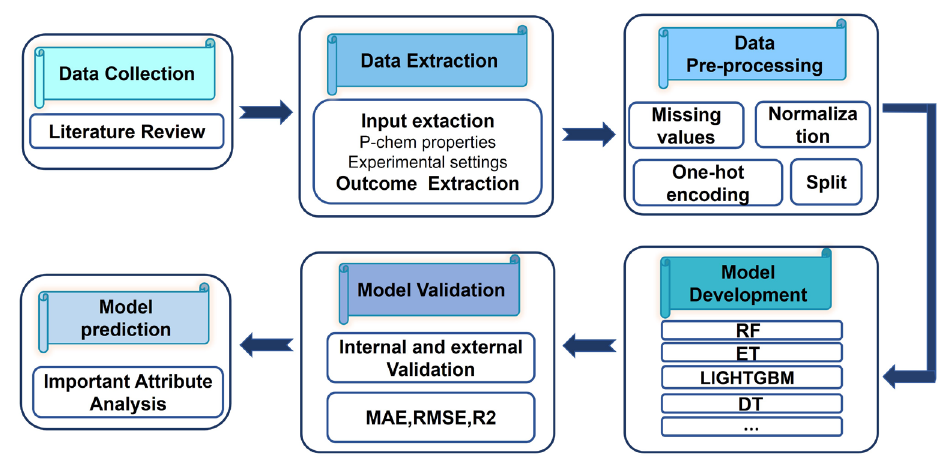
Figure 5. Model development workflow.